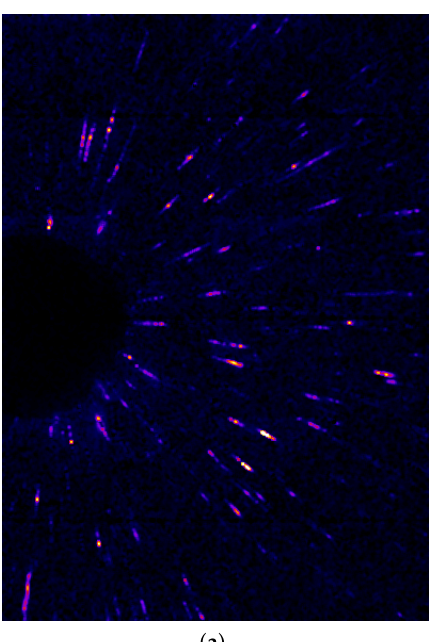
Figure 9. Laue pattern with threshold X-ray energy of 69 keV at position P 1 . This diffraction image includes the diffraction points that were obtained over the threshold X-ray energy of 69 keV. The sample was an austenitic stainless steel.